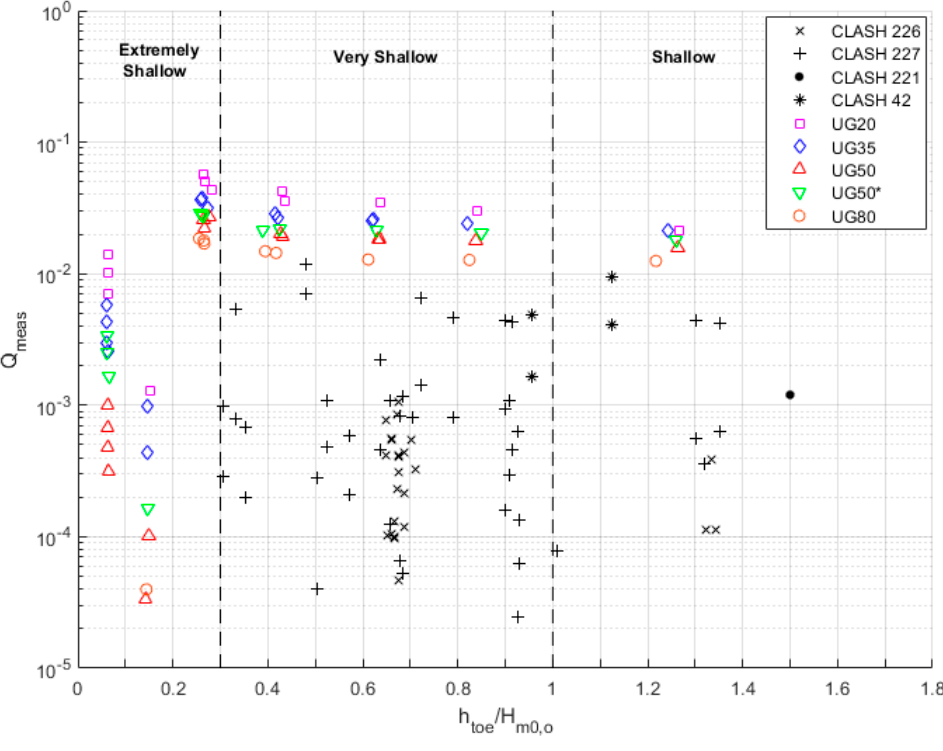
Figure 3. Variation in the dimensionless overtopping discharge versus ratio of the water depth at the toe and the deep-water wave height (relative water depth).